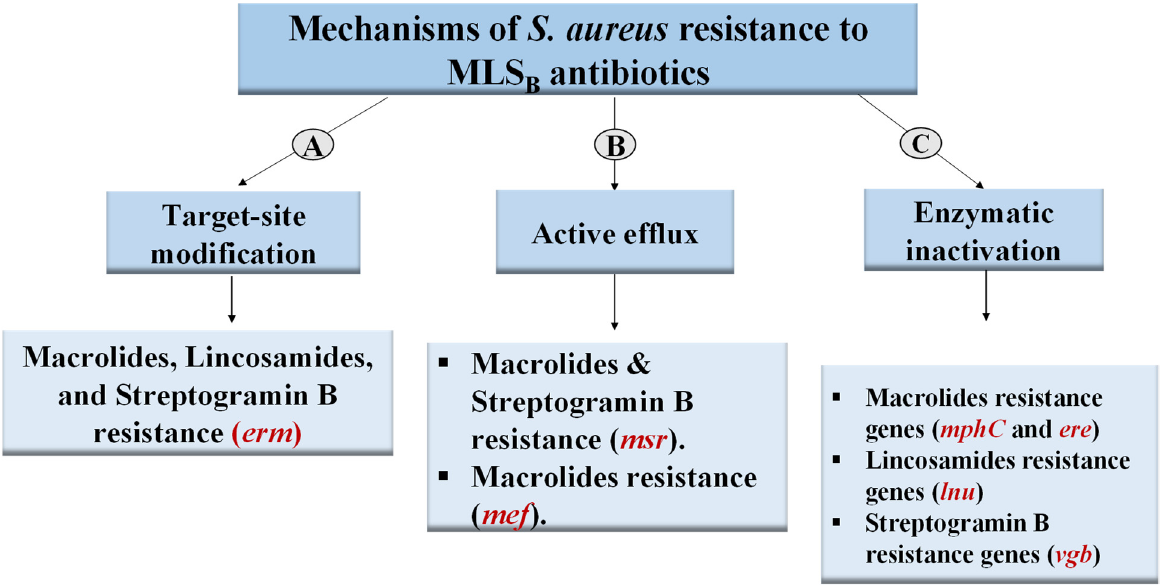
Figure 1. Mechanisms of S. aureus resistance to MLS B antibiotics. MLS B : macrolides-lincosamides- streptogramin B.